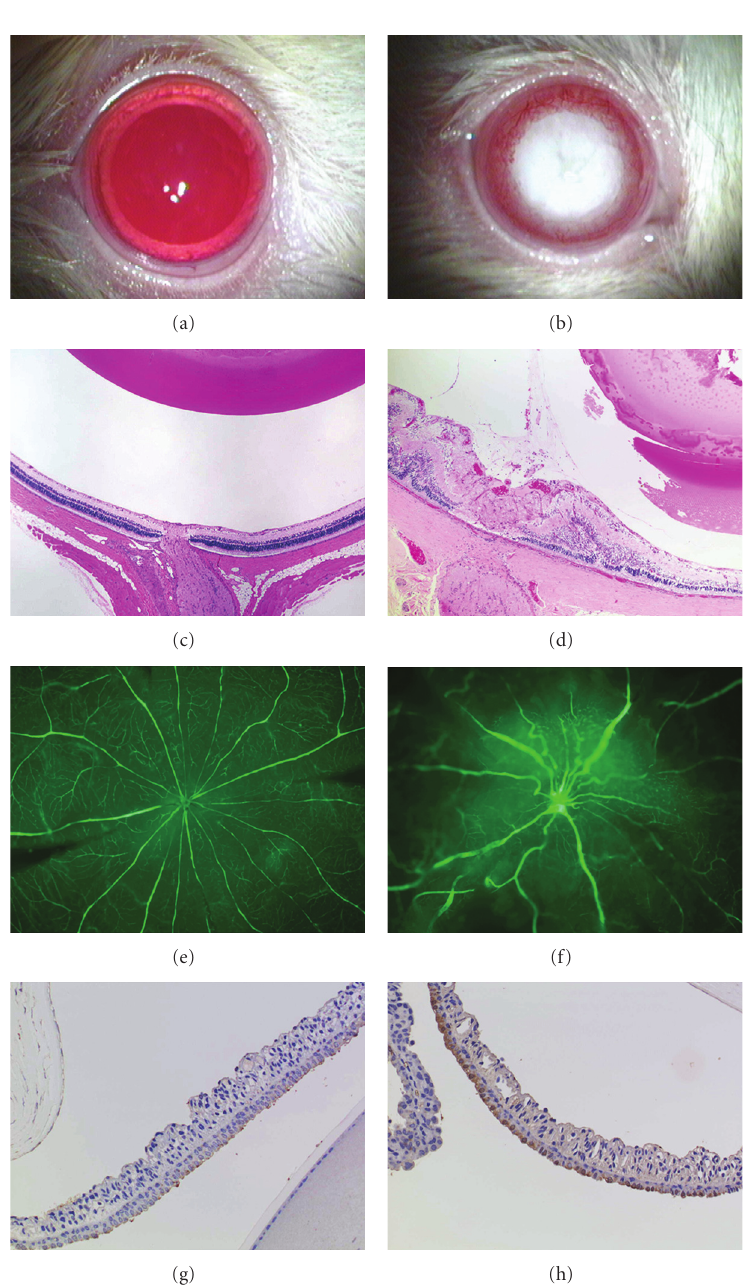
Figure 2: Typical ocular observations in control male SD rats (a, c, e, and g) and SDT rats (b, d, f, and h). (a) and (b) macroscopic photographs of eyes. Hypermature cataract is observed 100% in male SDT rats by 40 weeks of age. (c) and (d) histopathological changes in lens and retina at 80 weeks old. Proliferative fibrovascular membrane in vitreous is found around the optic disk. Retina is locally thickened and formed a fold. Disintegration of lens is also observed. H&E stain. (e) and (f) fluorescein angiomicroscopy at 80 weeks of age. Abnormal vascular formation, including venous dilation and meandering vascular networks, is characteristically observed in SDT rats. Extensive fluorescein leakage is found around the optic disk. (g) and (h) anti-VEGF staining of iris at 80 weeks of age. VEGF immunoreactivity is increased in iris of SDT rats. This may cause a massive hemorrhage on iris in some severe cases.